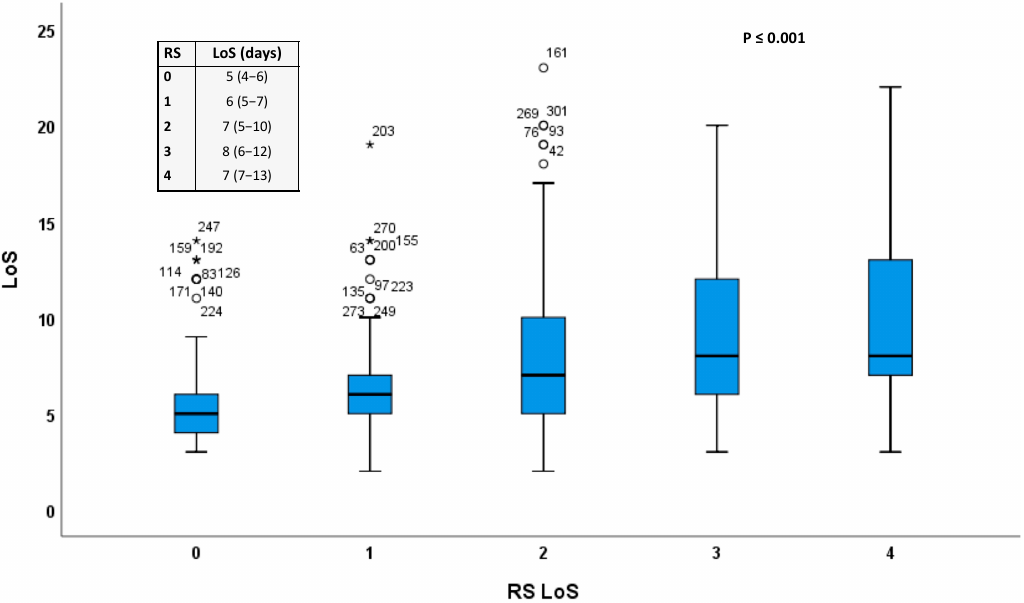
Figure 2. Distribution of LoS as a function of the calculated RS. Legend of Figure 2. Box plots depicting LoS (in days after TAVI), depending on the cumulative number of the aforementioned four predictors (RS_LoS range = 0 − 4). Within the box on the upper left corner of the figure the RS Score (0 − 4) is provided on the first column and the respective median numerical values, including the interquartile range within parentheses, are provided on the second column.